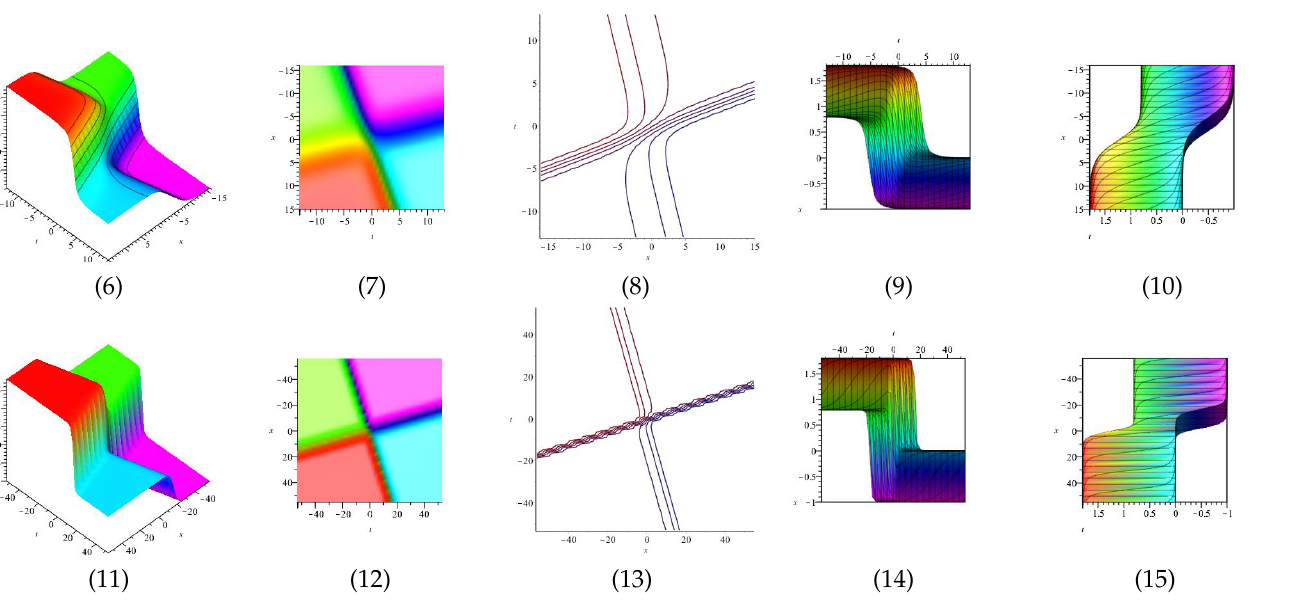
( x , t ) , in three different domains, for 3,1